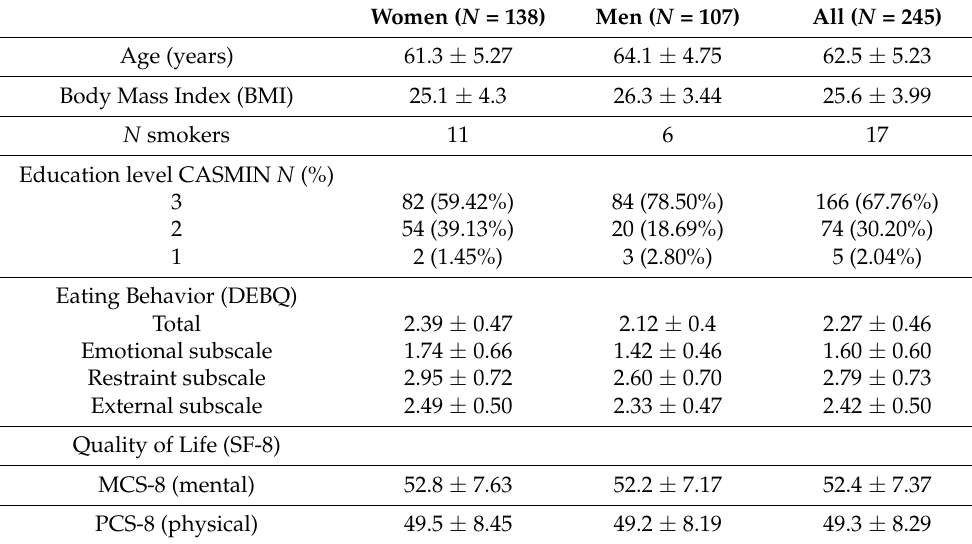
Table 1. Demographics of participants. Means ± Standard